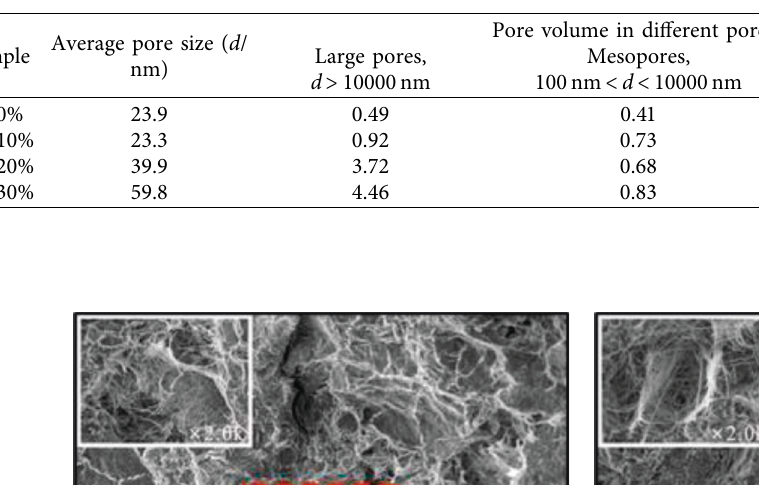
Table 3: Pore size distribution of cement-soil with different HA content λ .